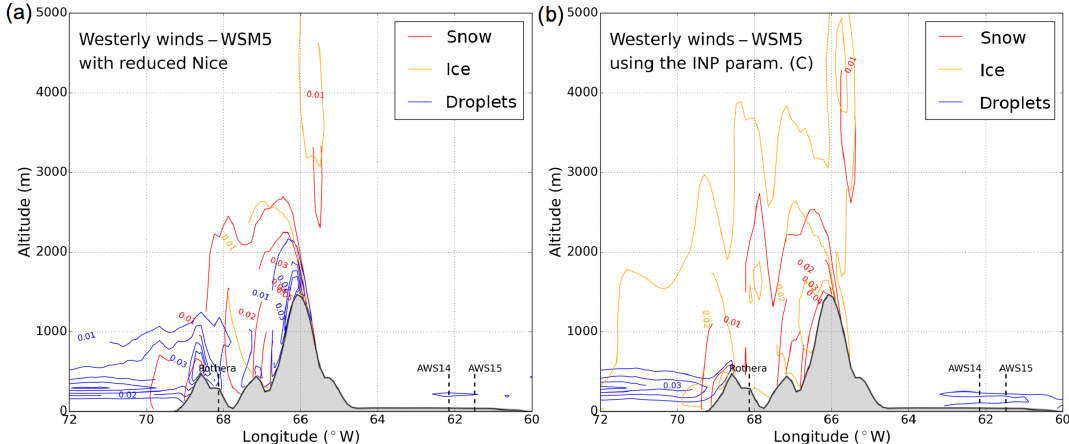
Figure 11. Same as Fig. 5a but with (a) a modified version of WSM5 where the empirical relationship linking the number of ice crystals to IWC is altered (see text for details) and (b) a modified version of WSM5 where the INP parameterization used (Fmod) is changed to (C) (Cooper, 1986), which predicts fewer INPs (see Sect.